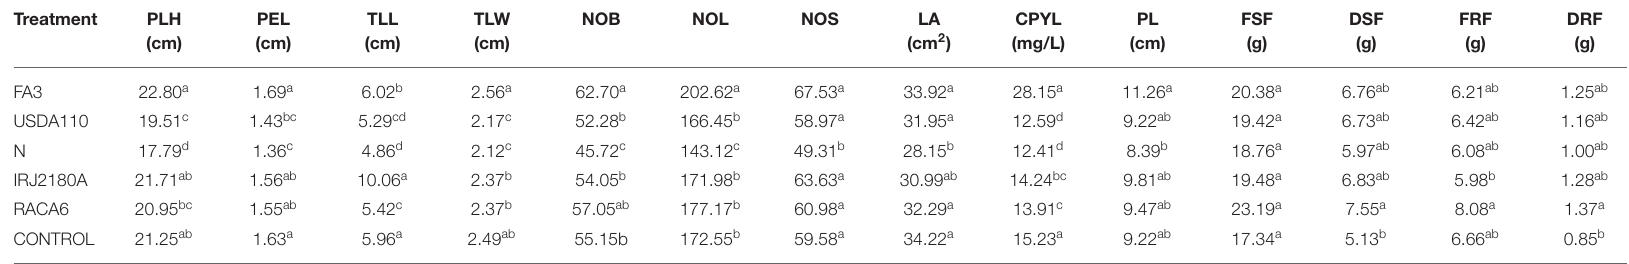
TABLE 5 | Effect of N fertilizer and B. japonicum strains on growth traits and biomass yield of accessions of Bambara groundnut at 12 WAP in Ibadan and Ikenne in the second season, 2020.